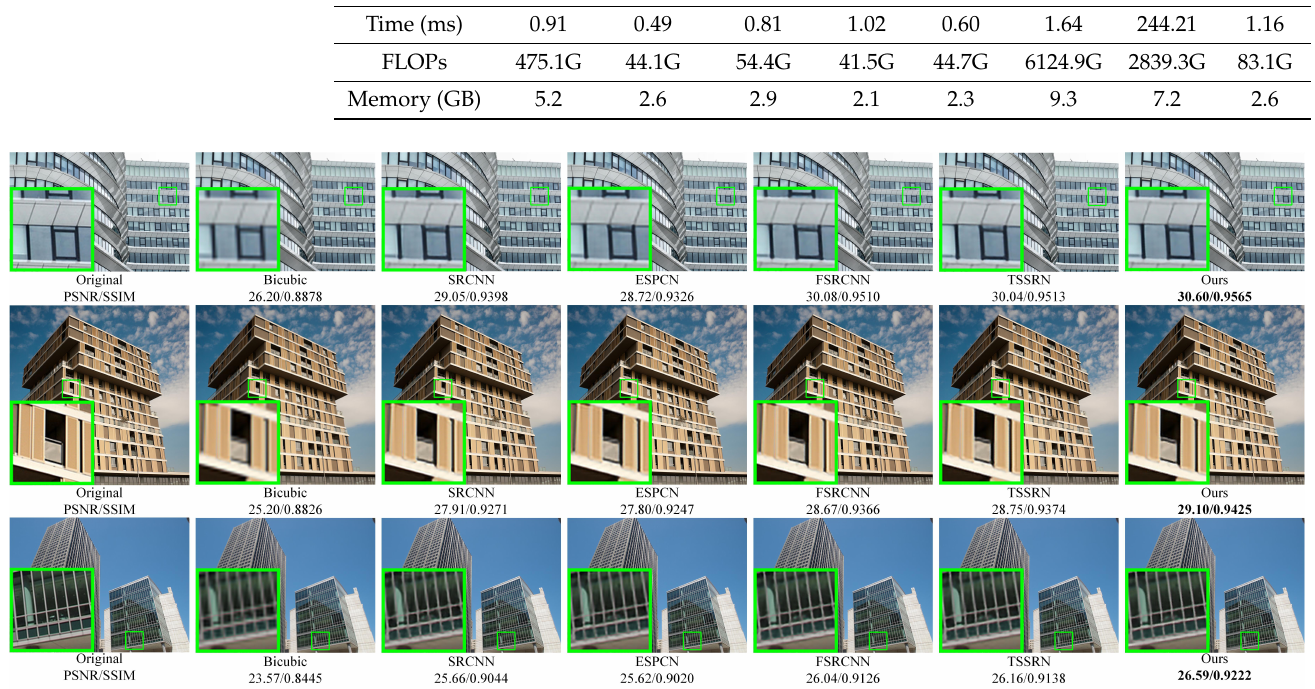
Figure 5. The “052”, “087” and “096” images from the Urban100 dataset with an upscaling factor of